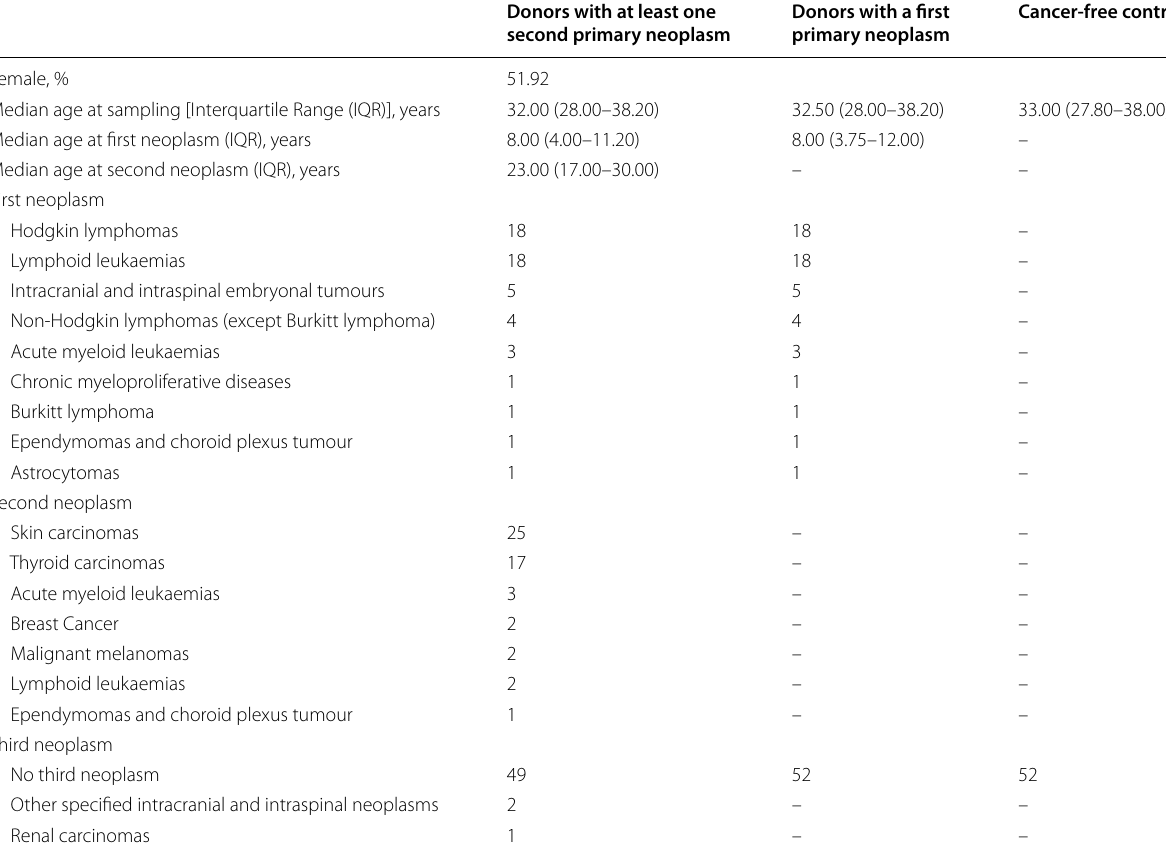
Table 1 Description of participants (N